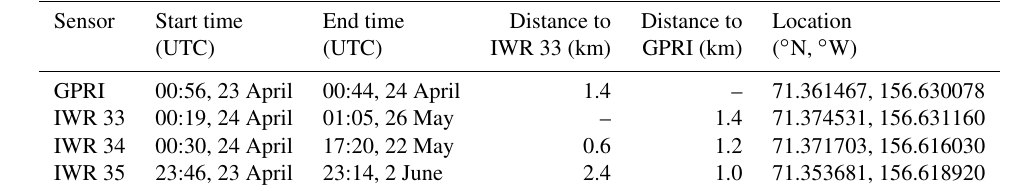
Table 1. Location and time of observations.